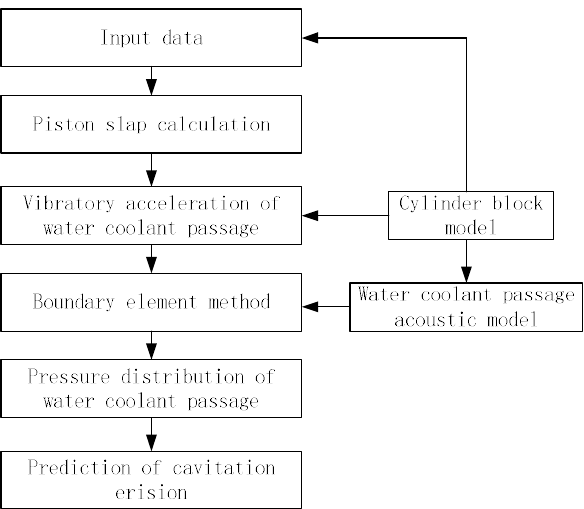
Figure 14. Logic flow of calculation.